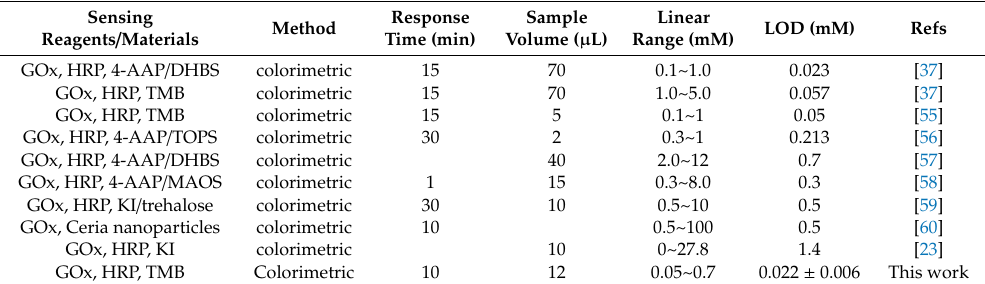
Table 2. Comparisonoftheparametersachievedforglucoseassayperformedonsensorsfoundinliterature.